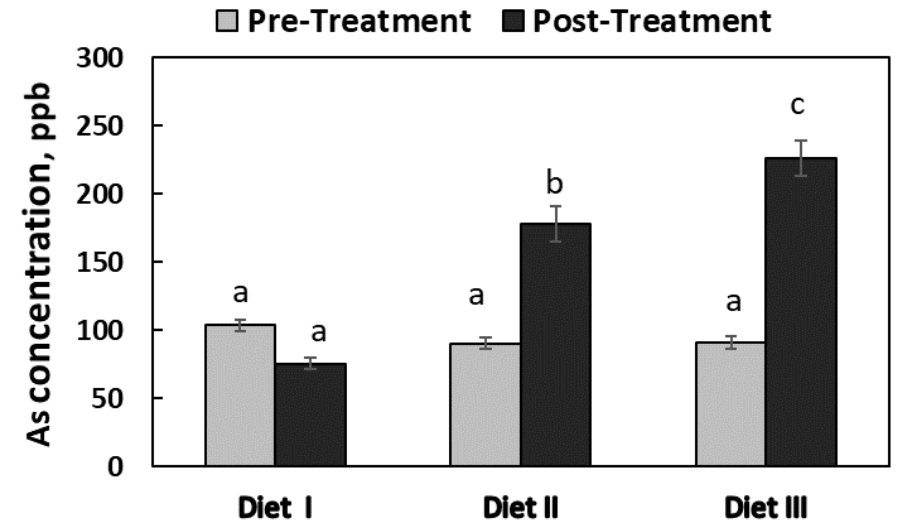
Figure 2. The concentrations of arsenic (As) in the hair of the pigs fed with three experimental diets. The rectangular bars represent the pattern of mean As concentrations in the hair before and after the feeding trial (pre- and post-treatment; n = 6 for Diet I, and n = 7 for Diets II and III). The error bars represent the pooled standard error of the means. The means labeled with different letters (a, b, c) differ ( p < 0.05).